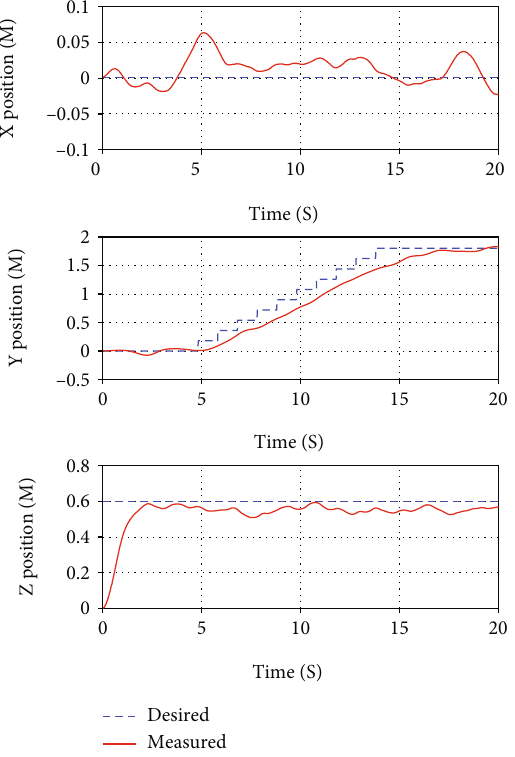
Figure 7: The position of the mass center of the entire system in the test in Y direction.